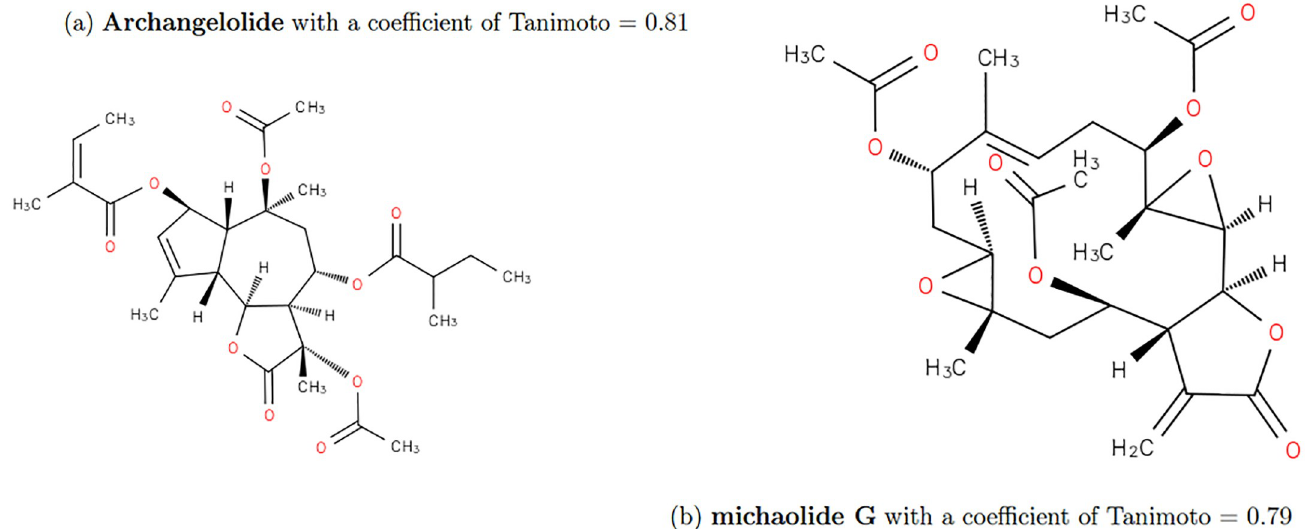
Fig 14. Results of similarity for Brevetoxine A on TC. (a) Archangelolide with a similarity of 0.81 (b) Michaolide G with a similarity of 0.79. These molecules does not have similar structure with Brevetoxin A.